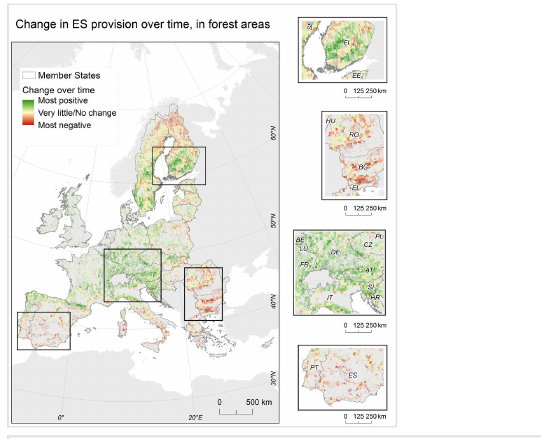
Figure 15. Change in ecosystem service provision over time (2050 vs. baseline) in forest areas over EU-28 (left) and close-up examples (right). Dark shades of green correspond to great positive change, and indicate areas with the greatest increase in ES provision, dark shades of red correspond to great negative change and indicate areas with the greatest decrease in ES provision. Maps are displayed using the Projected Reference System